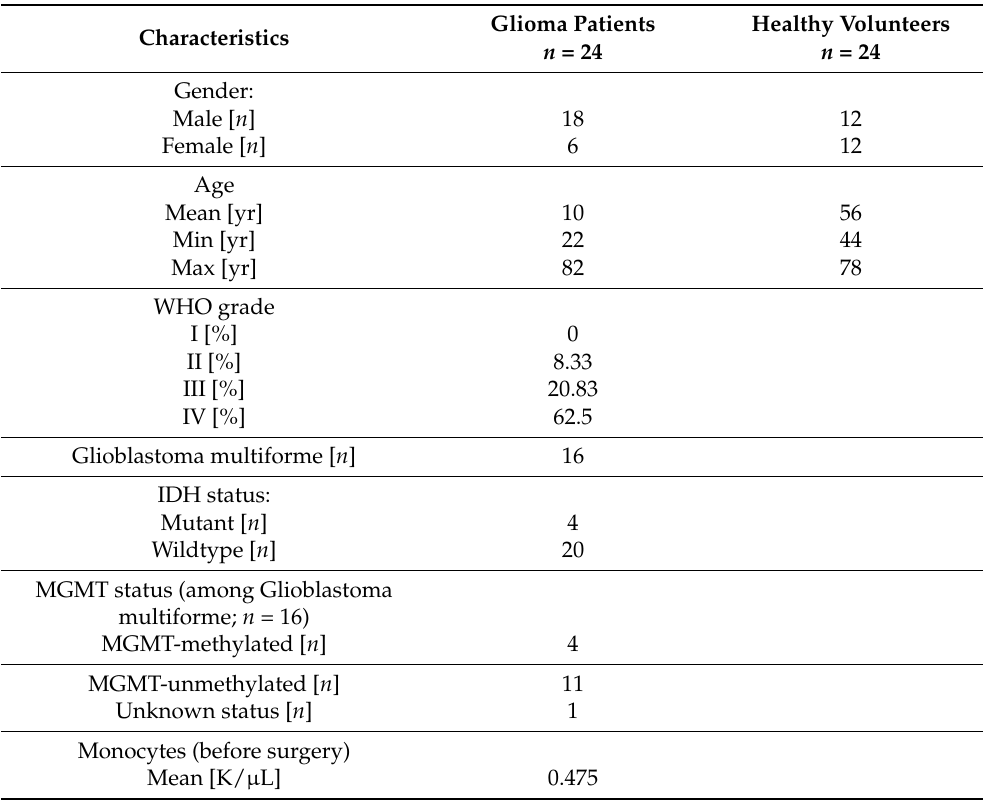
Table 1. Clinical characteristics of the cohort